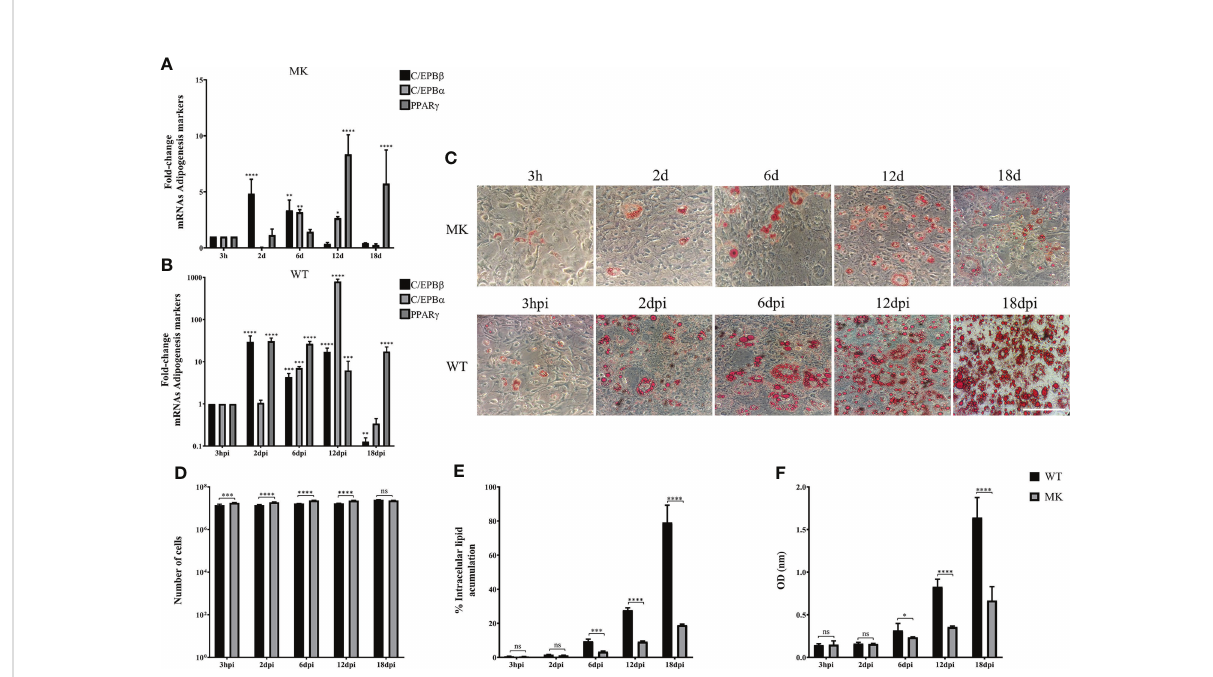
FIGURE 5 The effect of HAdV-D36 on 3T3-L1 adipogenesis is enhanced by adipocyte differentiation inducers. The effect of infection on 12 dpc 3T3-L1 cells cultured in MDI was evaluated. 12 dpc 3T3-L1 cells were infected with HAdV-D36 in the presence of adipocyte differentiation inducers (MDI) and the expression levels of C/EBP b , C/EBP a and PPAR g were analyzed by RT-qPCR (A, B) . Intracellular lipid accumulation was observed by ORO staining and white fi eld microscopy (C) . Scale bar = 100 m m. Cell numbers were measured using a Neubauer chamber (D) . Change in the percentage of cells with lipid accumulation in the presence of MDI were counted using ORO staining and white fi eld microscopy (E) the relative quantities of lipid accumulation were determined by elution of ORO staining, measured at 510 nm Optical Density (OD) (F) . Primers were designed to hybridize at exon-exon junctions to measure mRNA. All values represent the mean of two independent experiments, measured in technical duplicates. Data are expressed as the mean and error bars represent standard deviations. Signi fi cant differences from each time-point relative to 3h (A, B) and between Mock- and HAdV-D36-infected cells at each time-point (D-F) are indicated by *p < 0,05. **p < 0,005. ***p < 0,0005. ****p < 0,00001. ns, not signi fi